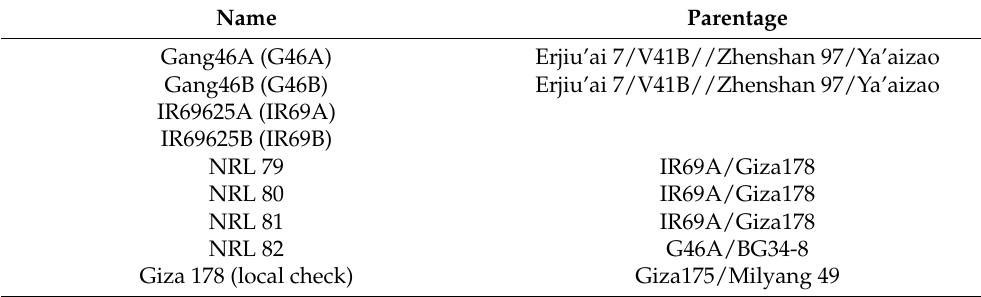
Table 1. Names and their parentage of the genotypes